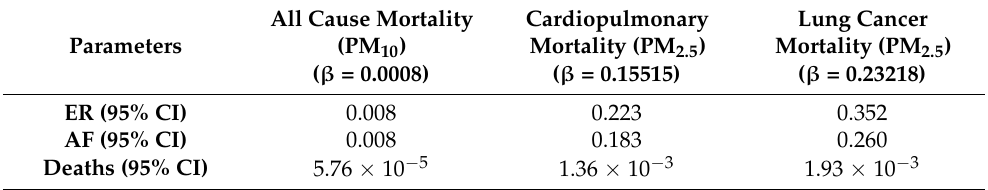
Table A10. Risk assessment from long-term exposure to PM, B.III method (Chalvatzaki, 2019).